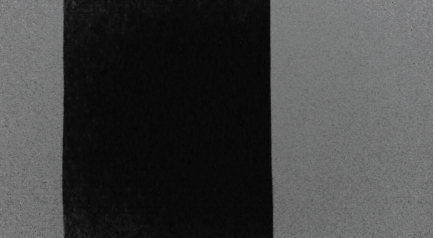
Figure 9. An image captured by the (RGB) SR305 camera where the black cardboard on the white wall (on the left) is visible.